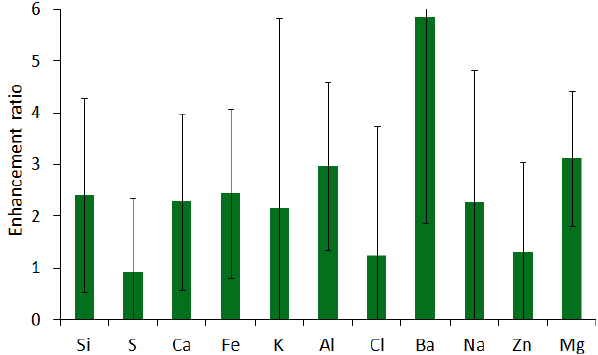
Figure 8. Enhancement ratio of elements in the monsoon season compared to the spring season in the Kathmandu